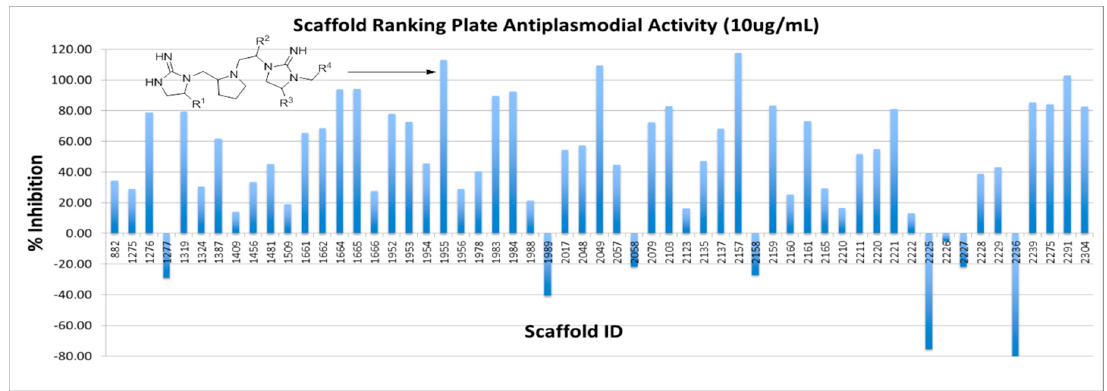
Figure 1. Screening of scaffold ranking library for antiplasmodial activity.